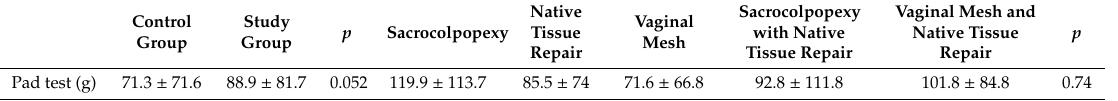
Table 3. The results of the 1-h pad test in both groups before sling implantation.